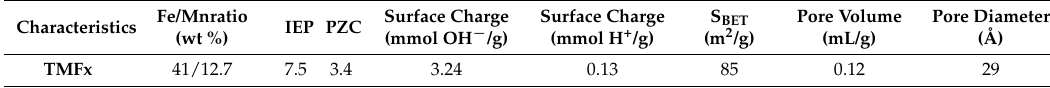
Table 1. Main physicochemical characteristics of tetravalent manganese feroxyhyte (TMFx) [27]. Fe/Mnratio Characteristics (wt